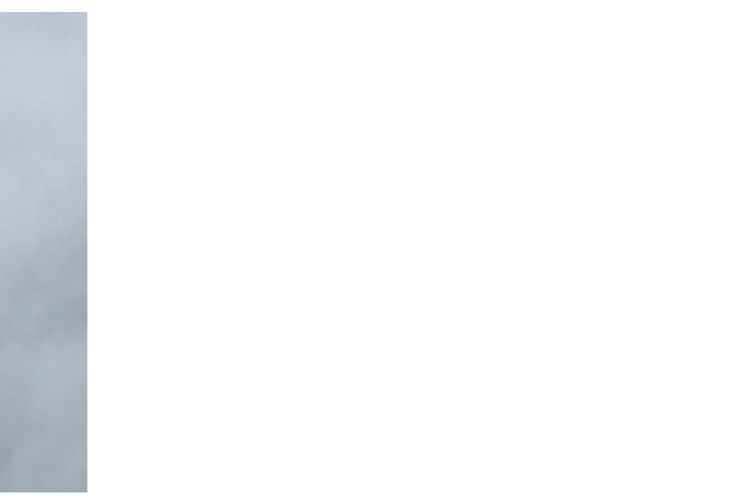
Figure 30. Balloon ascent, showing that the recovery chute (blue) was not in-line between balloon and capsule.